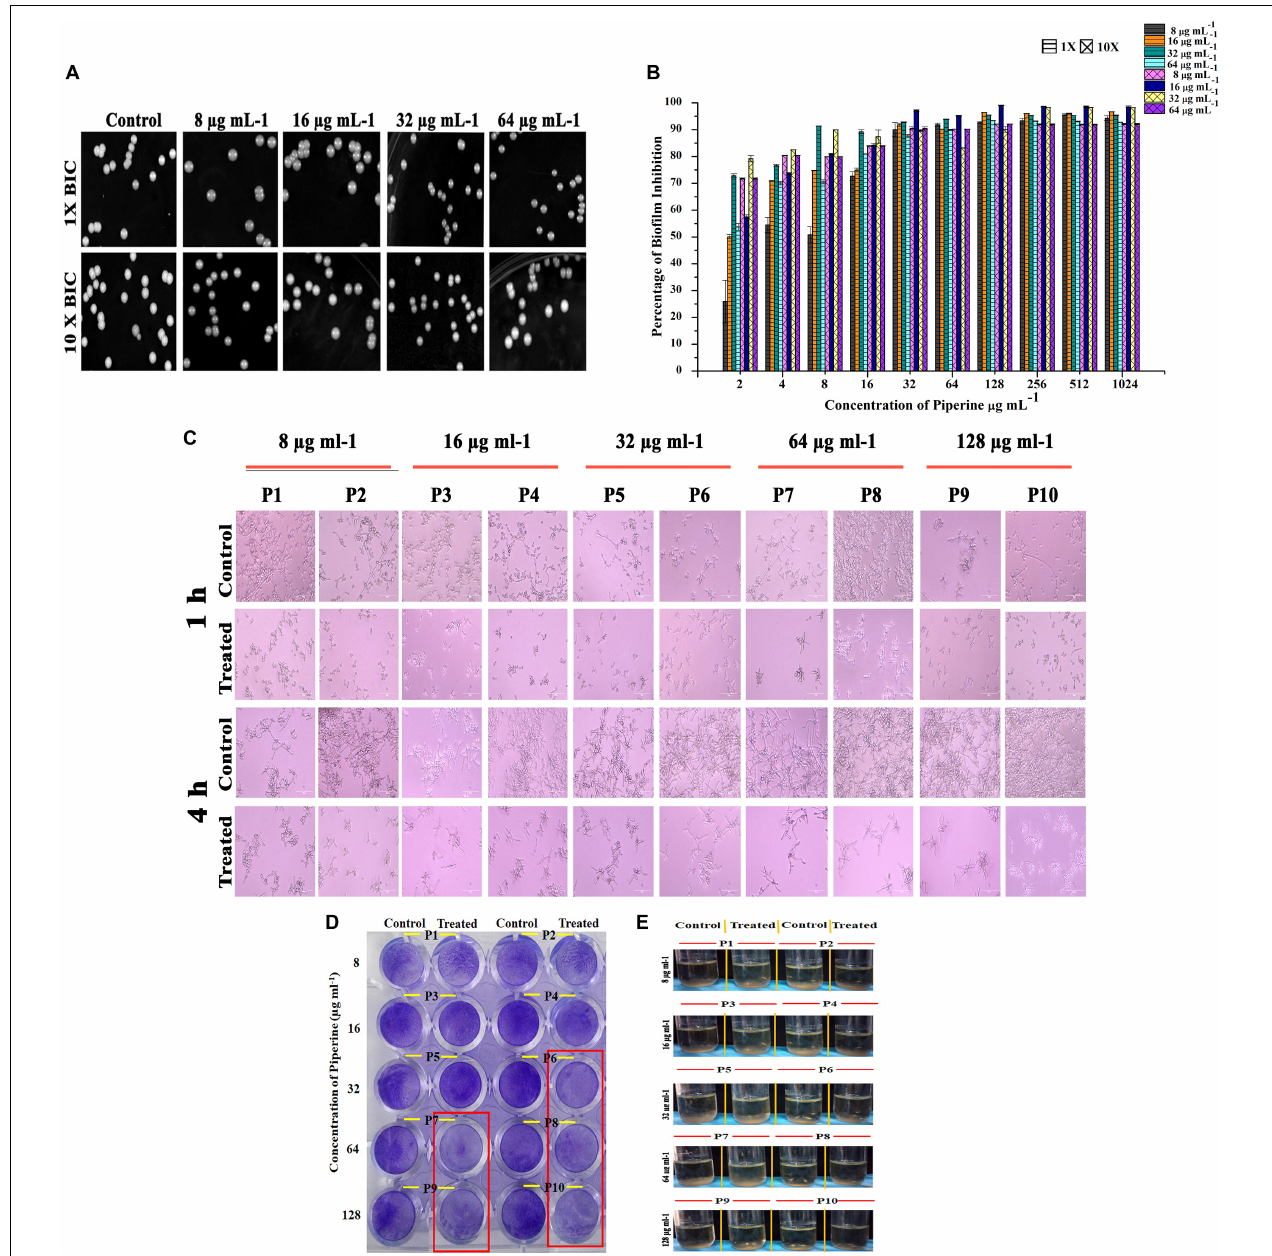
FIGURE 6 | Effect of piperine on spontaneous antibiofilm resistance development (A) Growth of C. albicans in piperine challenged plates. Top panel displays the C. albicans cells grown in the presence of 1 × of 0.25, 0.5, 1, and 2 × BIC. Bottom panel shows C. albicans grown under 10 × concentration of 0.25, 0.5, 1, and 2 × BIC. (B) Impairment in biofilm formation of piperine challenged C. albicans evidencing low potential for spontaneous antibiofilm resistance development. Error bars represent standard deviations from the mean ( n = 3). (C–E) Effect of subsequent passage of C. albicans with piperine from lower to higher concentration on (C) hyphal extension, (D) biofilm formation, and (E) flor formation (air–liquid interface biofilm